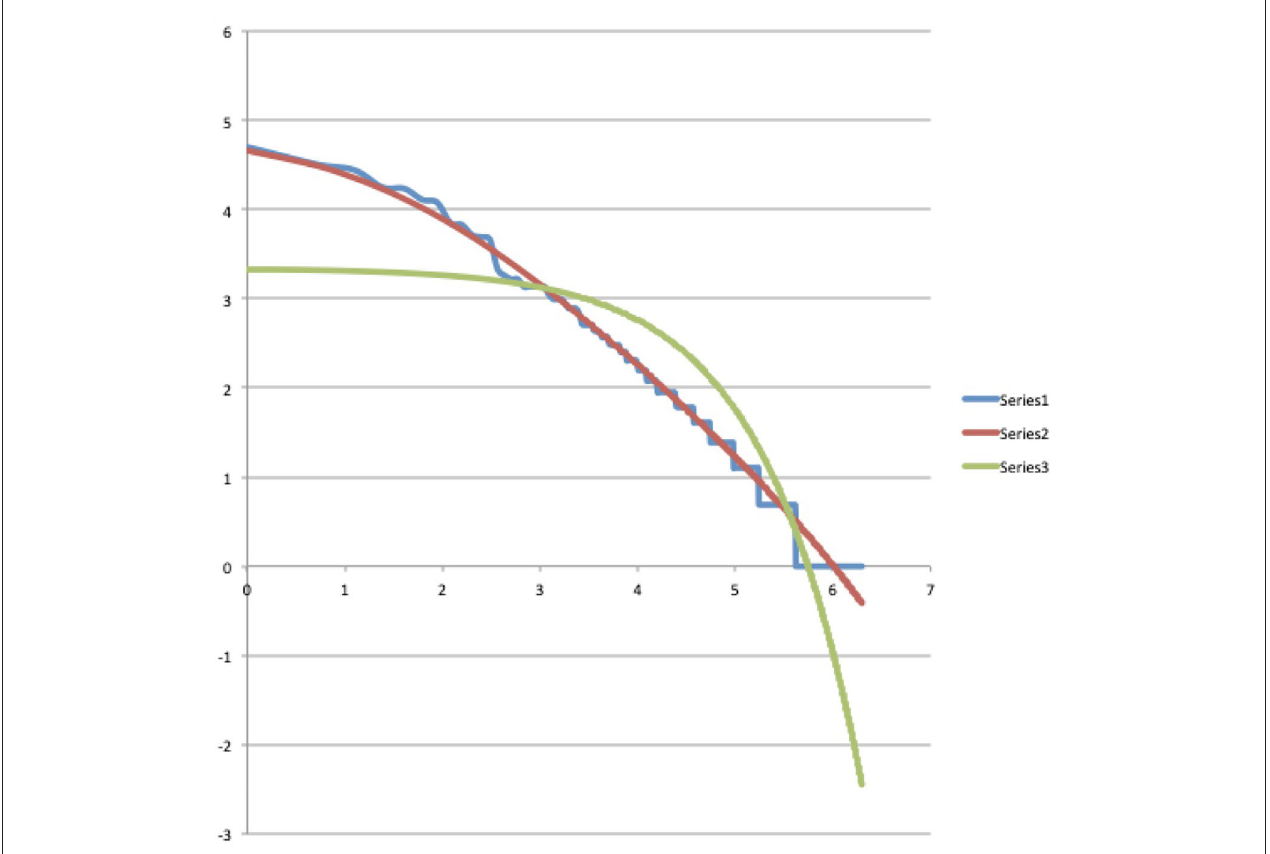
FIGURE 3 | Representation of the log / log graphs of the “numbers of appearances” and their Bose-Einstein and Maxwell-Boltzmann models. The red and blue graphs coincide almost completely in both whereas the green graph does not coincide at all with the blue graph of the data. This shows that the Bose-Einstein distribution is a good model for the numbers of appearances, while the Maxwell-Boltzmann distribution is not.